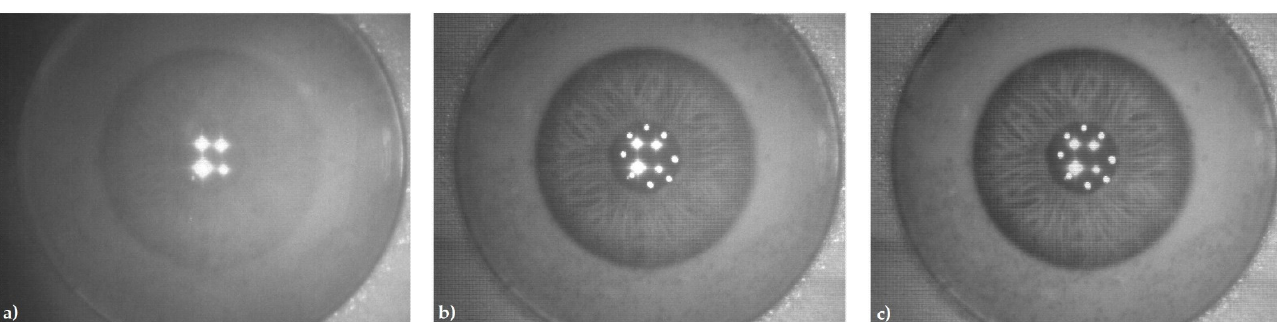
16 of 20 Figure 13. Measured image sharpness as a function of lens position at 3 fixed distances from the object: 70 mm, 100 mm, and 130 mm.